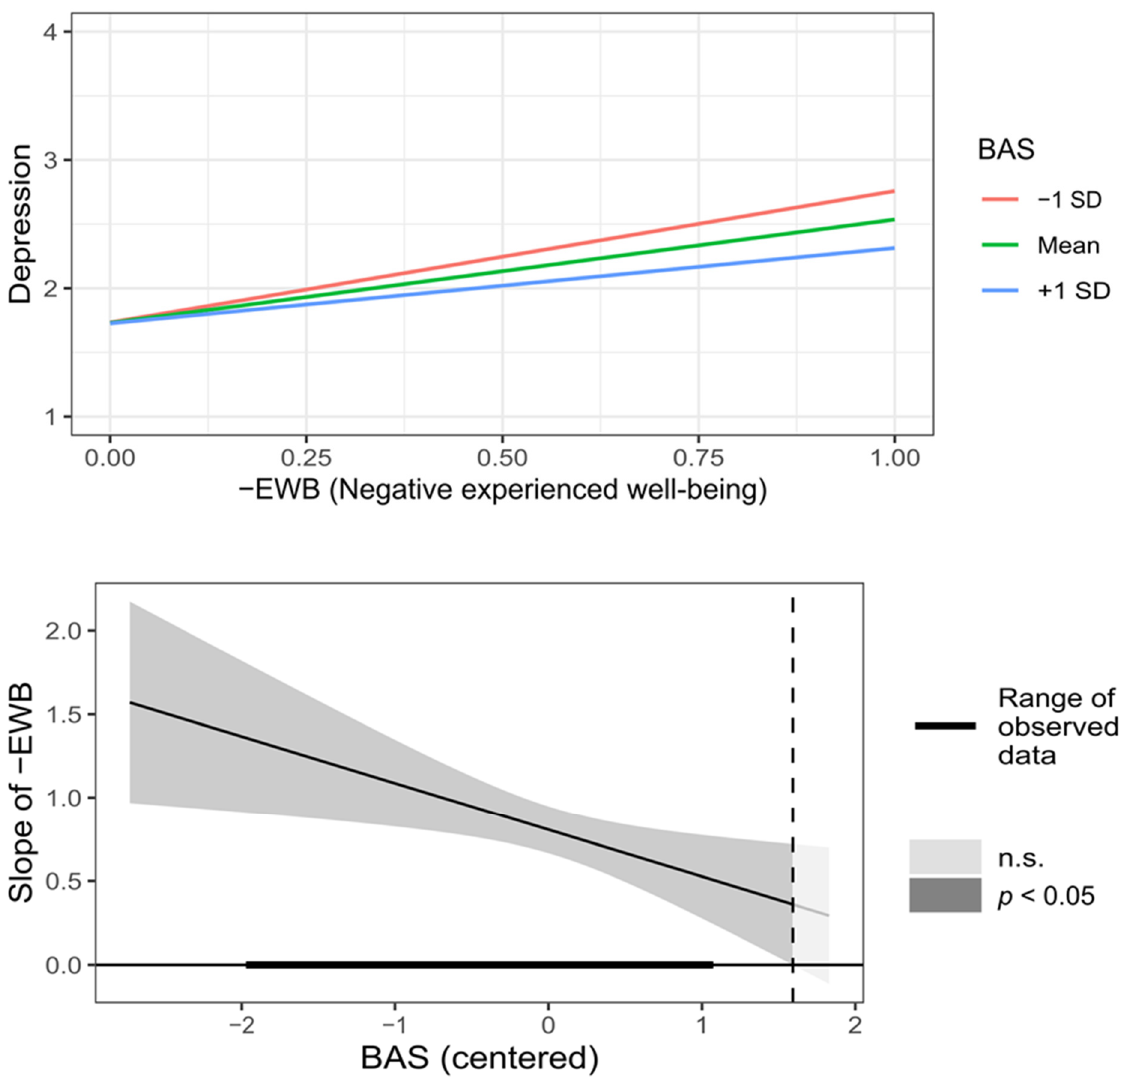
Figure 2. Graphic representation of BAS (Beliefs about stress) moderation on the relationship between − EWB (Negative experienced well-being) and depression symptoms.